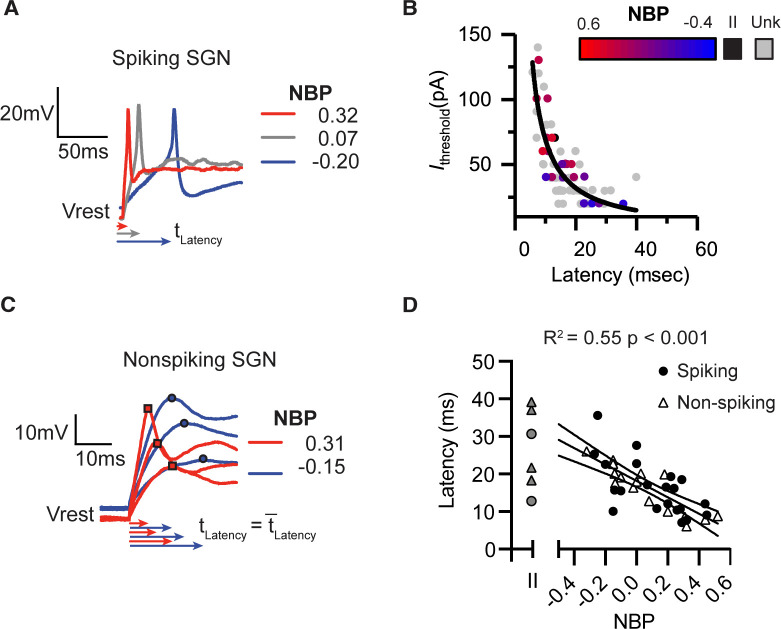
Response latencies are alternate predictors for normalized basal position.There is a significant inverse relationship between first-spike latency and current thresholds. Black line shows a fit Ithresh = constant/latency. Color transition from red to blue indicates position on NBP scale. Type II SGN are colored black. Unlabeled and therefore unclassified SGN are in gray. (A) First spike latencies compared between three spiking SGN with different NBP values. Latencies are faster for more positive NBP (B) In non-spiking neurons, response latency is computed by averaging the time from the onset of the stimulus until peak depolarization potential over a series of current steps. Similar to the dependence of first-spike latency, average response latency is faster for modiolar-contacting SGN (NBP >0, red) than for pillar-contacting SGN (NBP <0, blue). (C) Response latencies for all spiking (black dot) and non-spiking (triangle) neurons plotted against NBP. In both spiking- and non-spiking SGN, response latencies become faster as NBP values increase (R2 = 0.55, p<0.001). Latencies are highly variable across type II fibers (gray symbols).Figure 3—source data 1.Current threshold versus latency dataset for Figure 3B.Figure 3—source data 2.Latency versus normalized basal position dataset for Figure 3D.